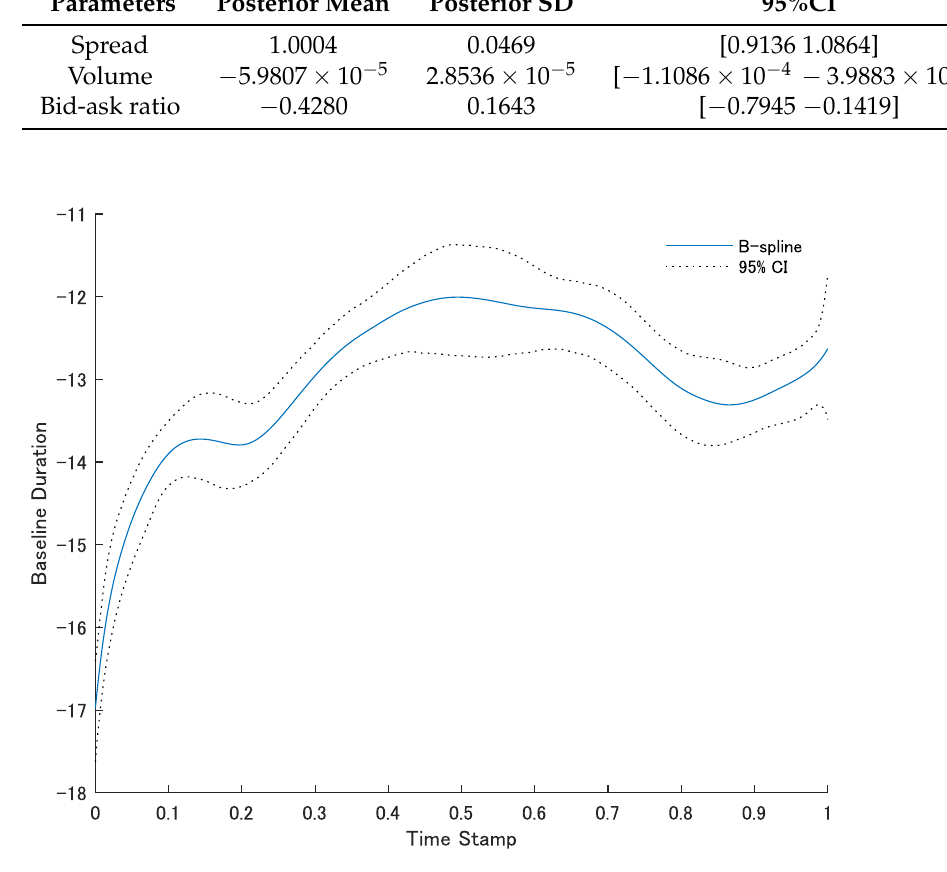
Figure 7. Intraday seasonality of time interval of JAL, Tokyo, Japan (4 January 2016).